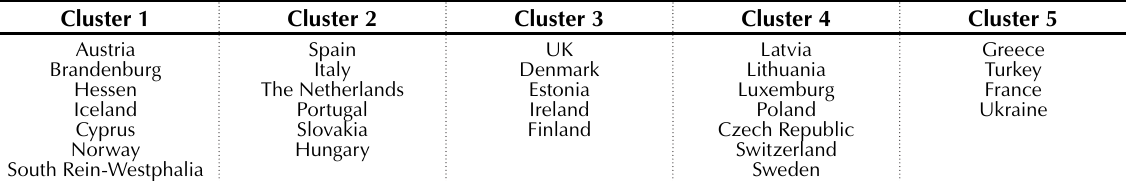
Source: Developed by the